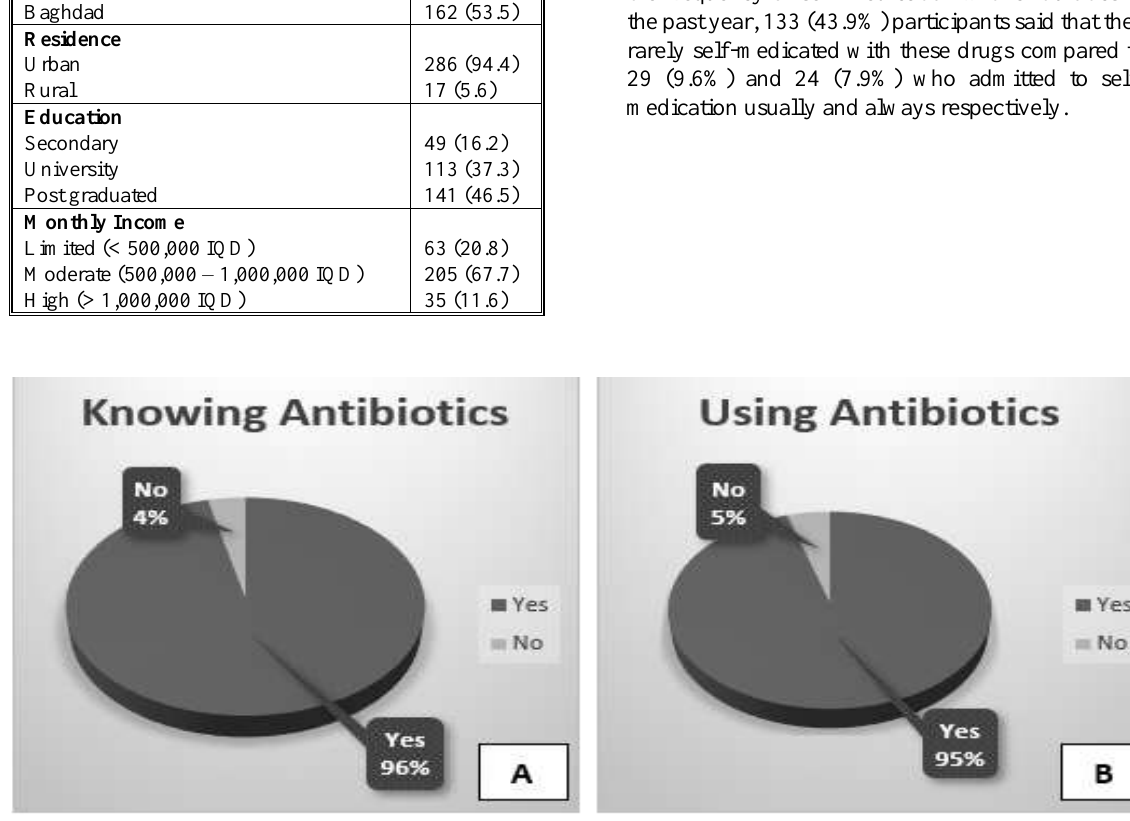
Figure 1. A. The of percentage participants having an antibiotics knowledge B. The percentage of participants who have used antibiotics in the previous two months